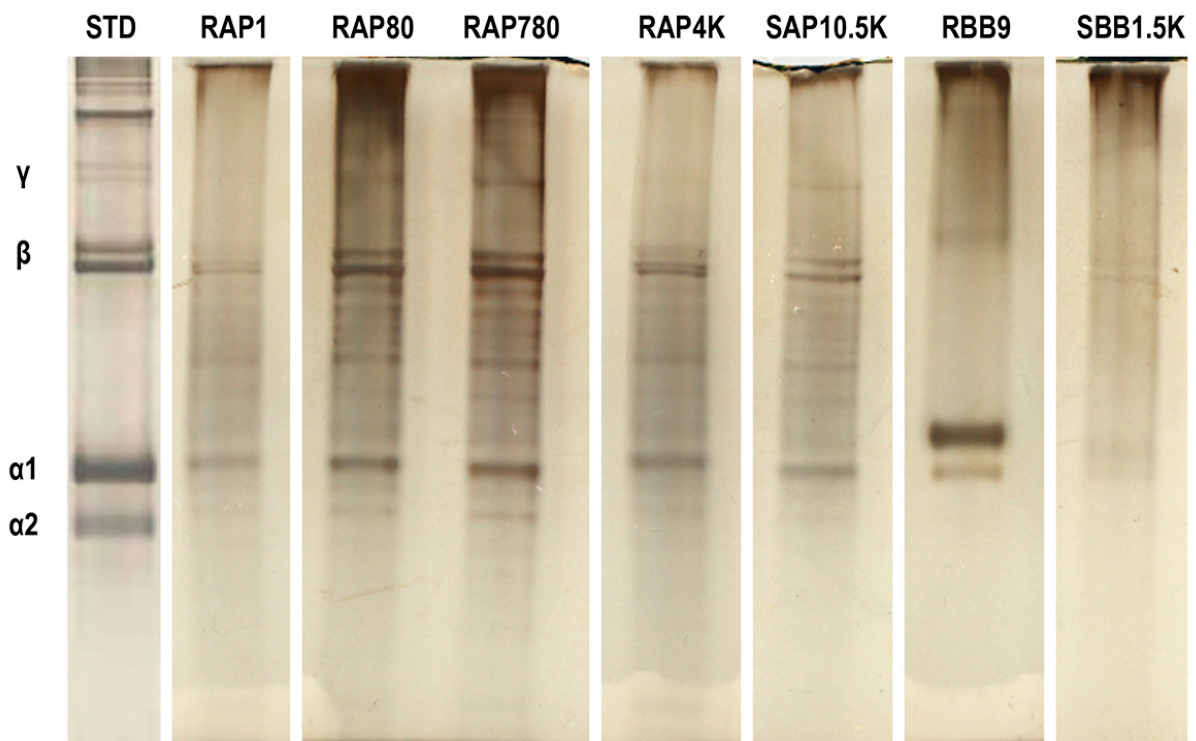
Figure 1. SDS-PAGE analysis of gelatin samples used in this study.